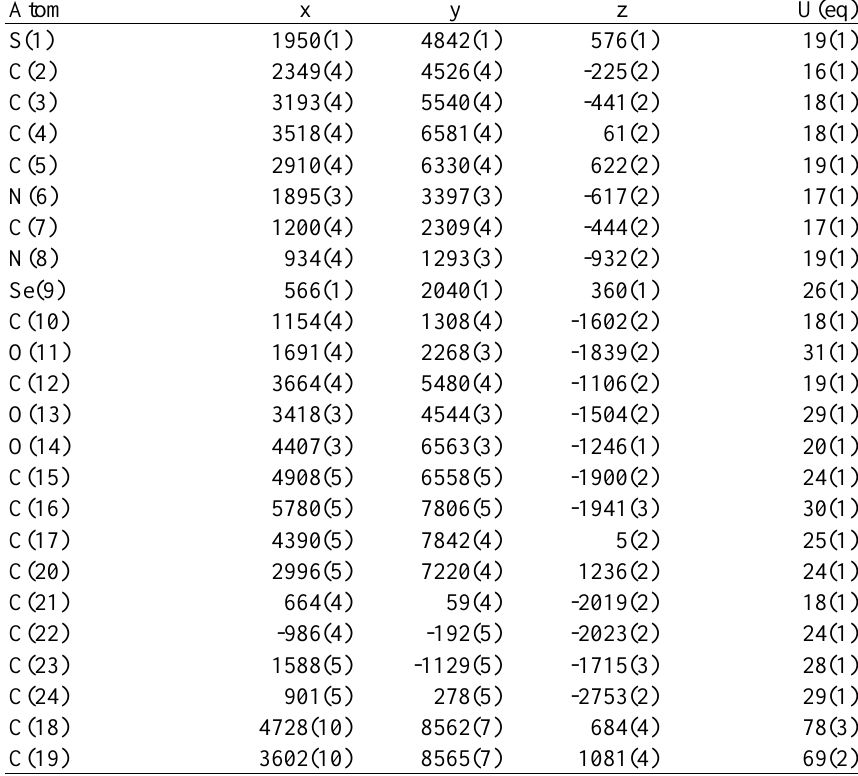
Table 5. Atomic coordinates (x 10 4 ) and equivalent isotropic displacement parameters (Å 2 x 10 3 ). U(eq) is defined as one third of the trace of the orthogonalized U ij